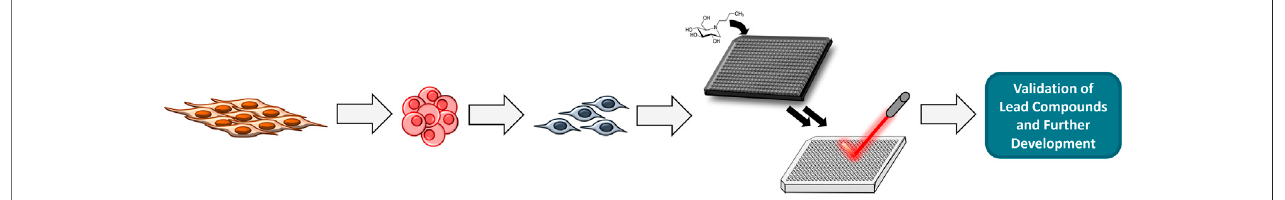
FIGURE3| Generalwork fl owforperformingHTS.Fibroblastsarereprogrammed intoiPSCswhichareprogrammed intoNSCs.